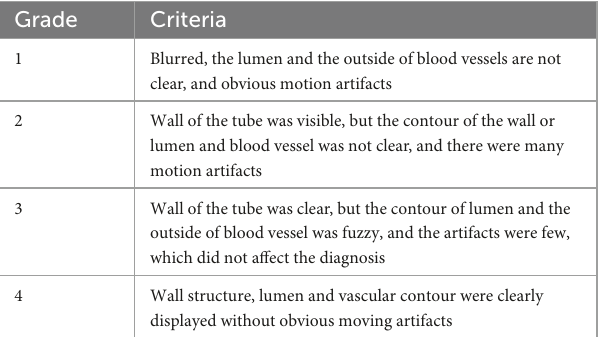
TABLE 1 4-point Likert criteria of carotid plaque